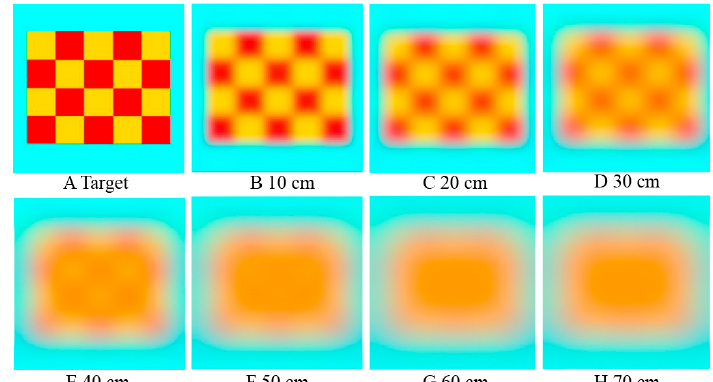
Figure 8. Simulations of the viewing distance of Empoasca onukii . ( A ) Target yellow/red pattern with 256 × 256 resolution. ( B–H ) Visual simulations of E. onukii viewing a 20 × 25 cm yellow/red pattern at different distances with a visual acuity of 0.14 cpd was conducted using the AcuityView package in R (V4.2.0).